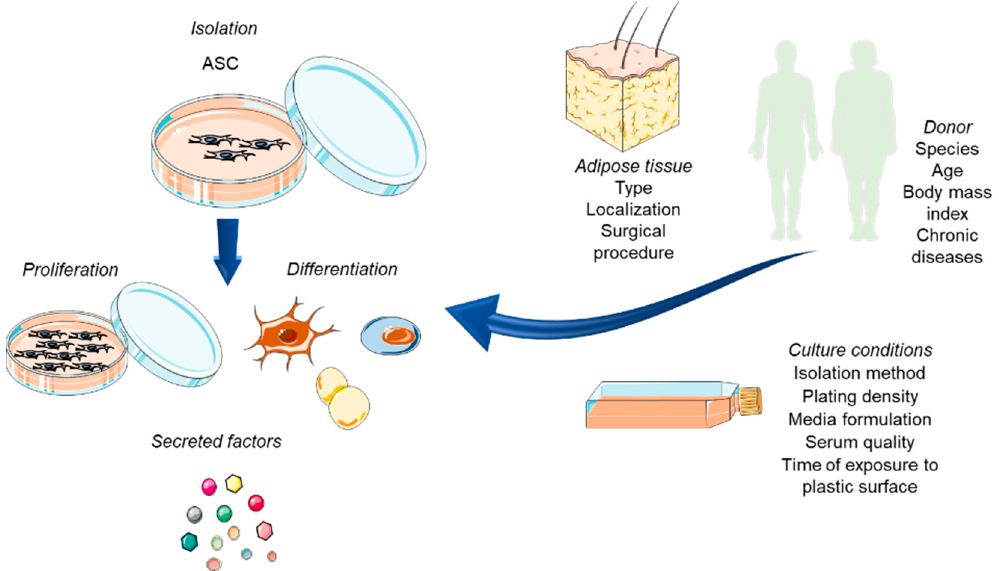
Figure 2. Isolation procedure of ASC. The variety of sources and the diversity of factors influencing ASCs biologic properties (proliferation capacity, differentiation potential, secretion of factors), increasing heterogeneity and leading to the isolation of differentiated subpopulations.